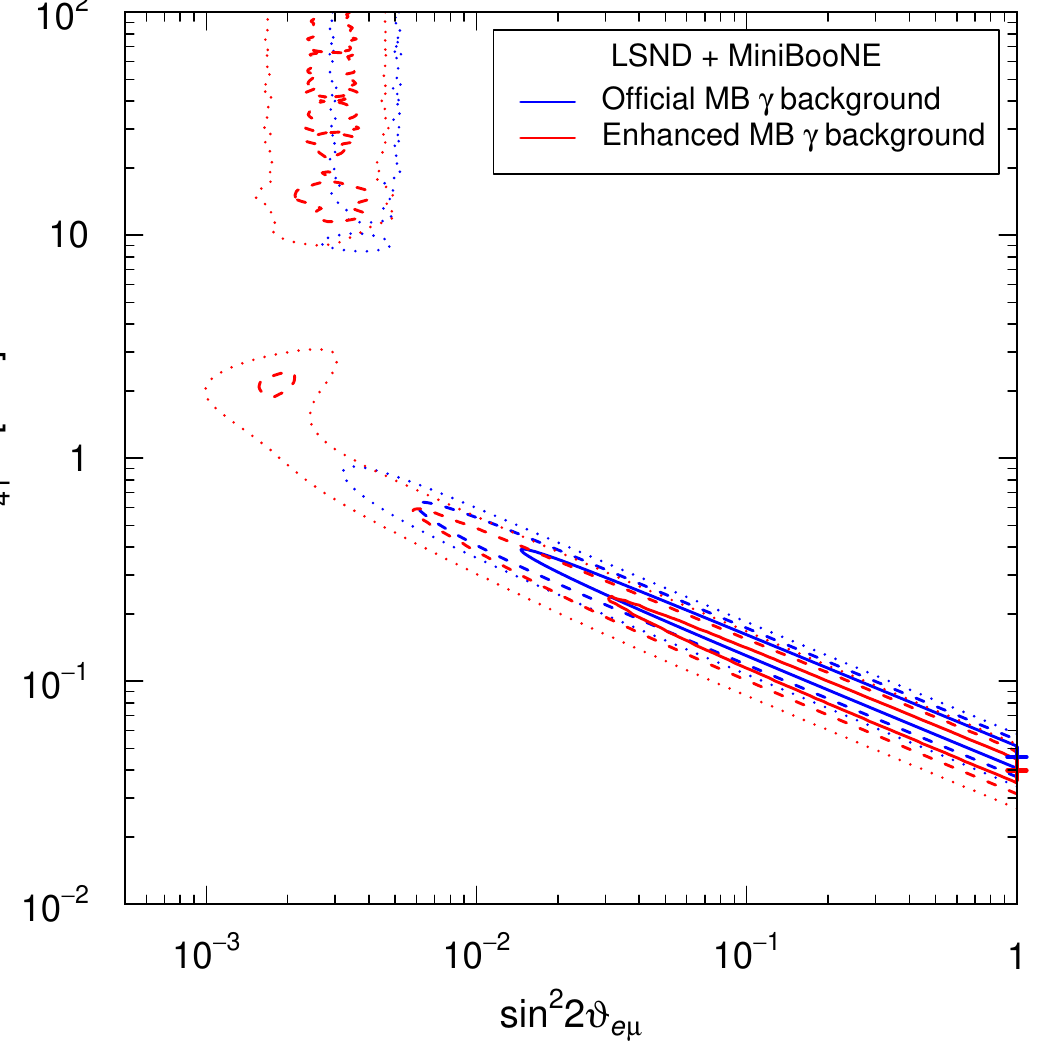
Figure 3 . Contours enclosing 1 σ (solid), 2 σ (dashed), and 3 σ (dotted) allowed regions in the ( sin 2 2 ϑ eµ , ∆ m 2 ) plane obtained from the analysis of LSND and MiniBooNE data without (blue) 41 and with (red) the enhanced single- γ